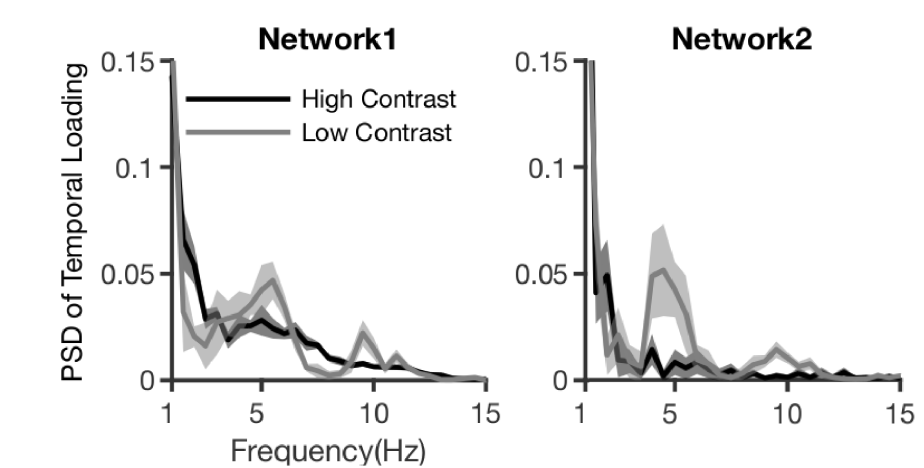
Fig 4. Spectral power of FF network dynamics. Fourier transformation of temporal dynamics for FF networks, for 2 contrast conditions. Shaded area indicates SD over bootstraps. Underlying data: https://osf.io/pqf7z. FF, feedforward.